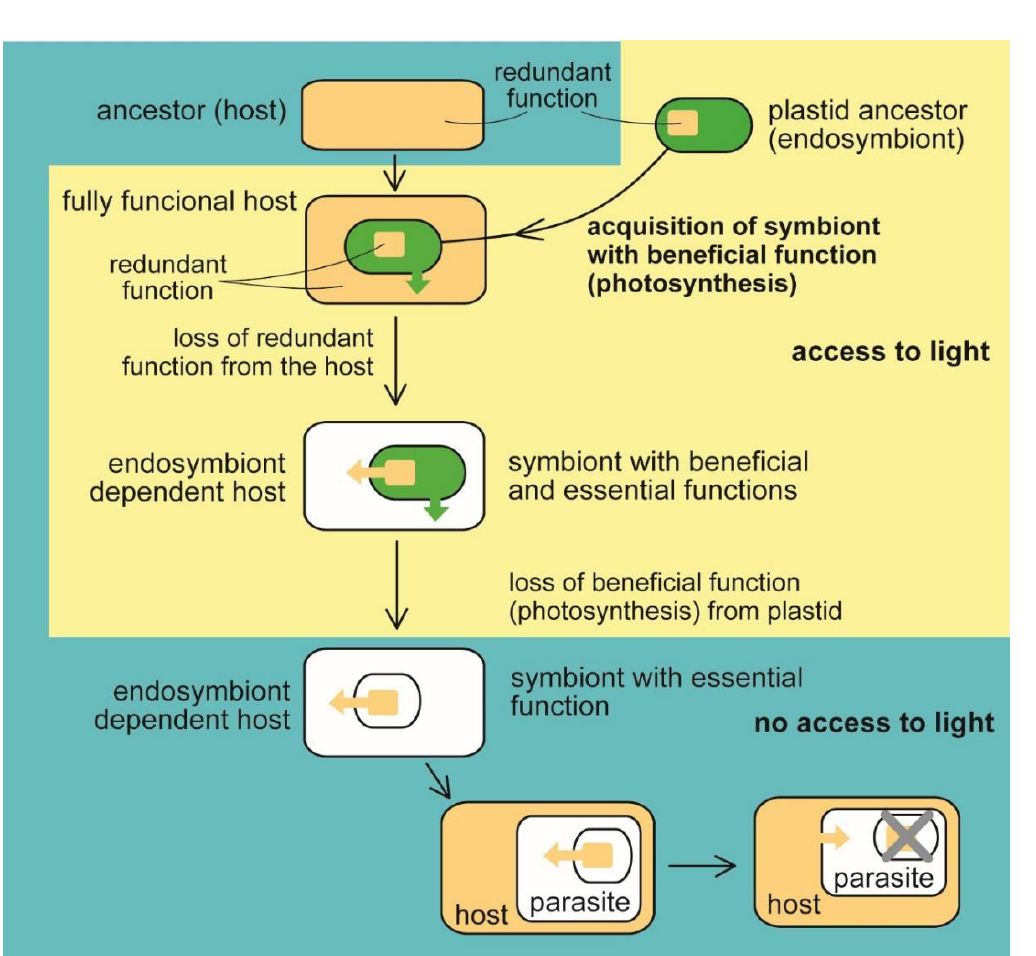
Figure 1. Evolution of benefit and essential function in the plastid. The heterotrophic host acquired a photosynthetic endosymbiotic bacterium with the function (photosynthesis) beneficial for the host. The host cell lost the redundant function (e.g., synthesis of heme, fatty acids, and isoprenoids). At the same time, the delegation of the syntheses to the endosymbiont makes it essential for host survival (eukaryotic phototrophs, e.g., Archaeplastida and Paulinella sp., and algae with complex plastids such as Ochrophyta, Cryptophyta, Haptophyta, Dinophyta, Apicomplexa, Euglenopyhta, Chlorarachniophyta [1 – 3,11]). The endosymbiont retained its indispensability for the host even when it had lost photosynthesis, the original beneficial function (in nonphotosynthetic algae, e.g., Helicosporidium sp., Polytomella sp., Euglena longa , apicomplexan parasites, for example, Plasmodium falciparum , Toxoplasma gondii [1–3,7,11] Table 1). Switching to parasitism and scavenging the essential compounds from the host allows the complete loss of the plastid (apicomplexan parasite Cryptosporidium [42], parasitic dinoflagellate Hematodinium